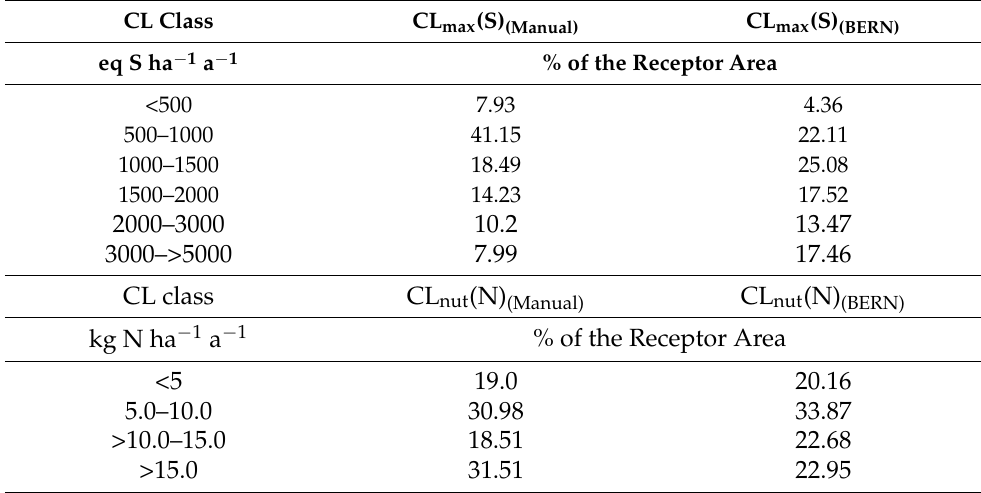
Table 25. Comparison of the critical loads and critical limits calculated according to SMB from the Mapping Manual [11,14] with those including vegetation-specific limits derived from the BERN model by the